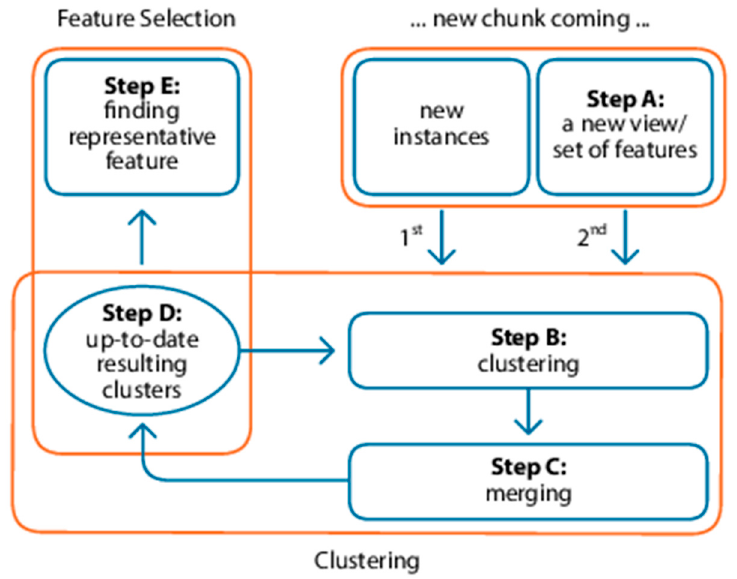
Figure 3. An overview of UFODMV method. In step A, a new chunk received from a data stream that has new instances and a view. In step B, the new instance and features set are clustered. In step C, the resulting clusters from step B are merged to the predefined reduction size. In step D, clusters are incrementally updated with new corresponding values. In step E, the representative features are selected from up-to-date